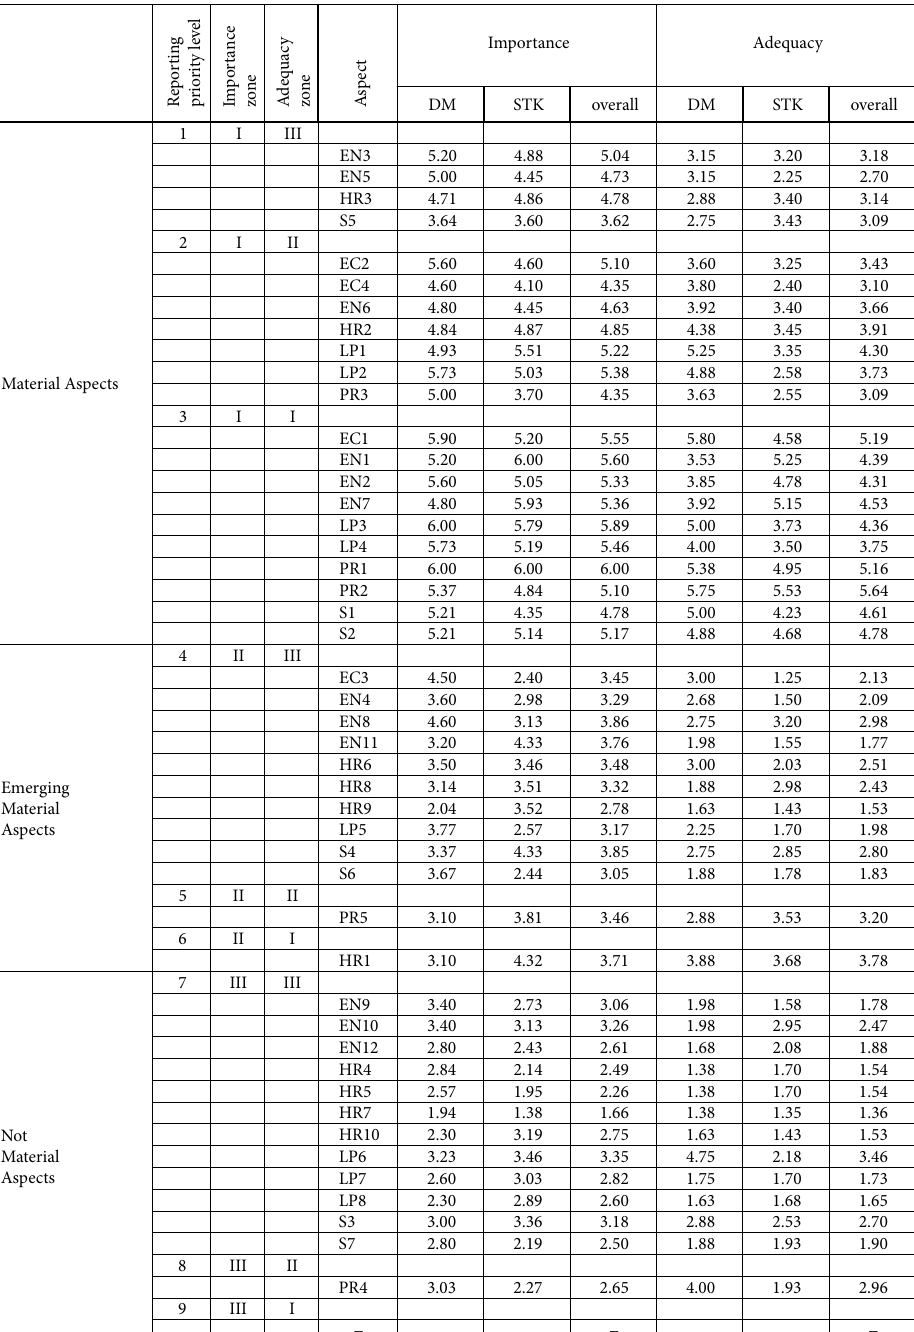
Table 4. Priority levels and results for decision makers (DM), stakeholders (STK), and overall in the ACMO